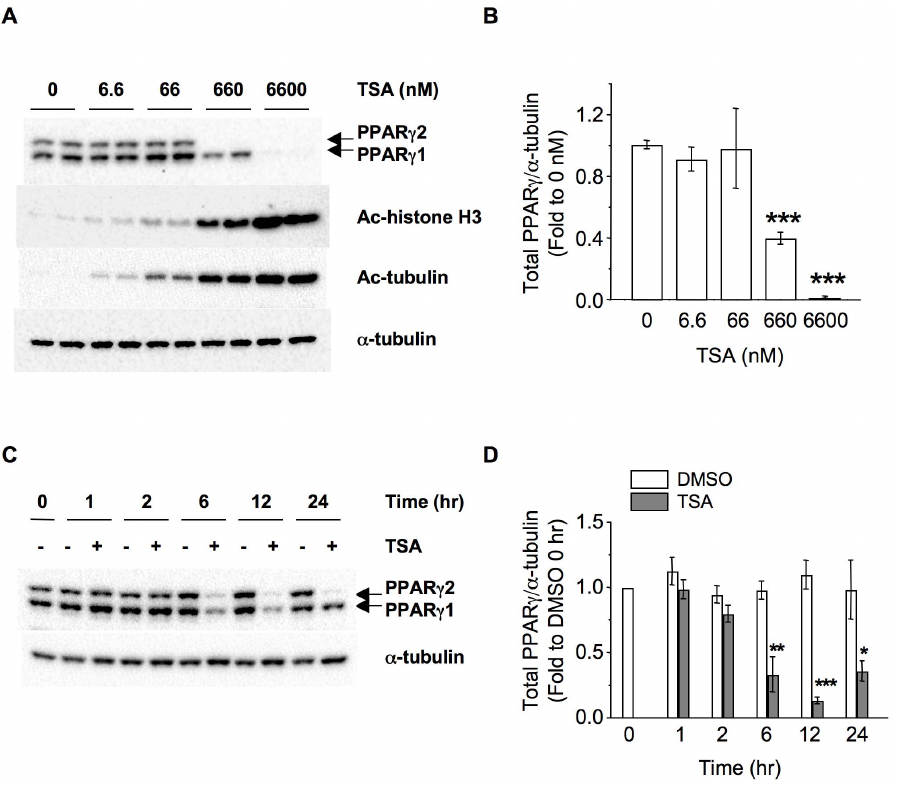
Figure 6. Down-regulation of PPAR c by TSA treatment is dose- and time- dependent. (A, B) 3T3-L1 adipocytes were treated in duplicate with increasing TSA doses (0, 6.6, 66, 660, 6600 nM) for 24 h. Cellular proteins were solubilized and subjected to SDS-PAGE and Western blot analysis with the indicated antibodies. Representative immunoblots from three independent experiments were shown in 6A. Quantification data for total PPAR c are shown in 6B. Asterisks denote significant differences compared with 0 nM control (***p , 0.001). (C, D) 3T3-L1 adipocytes were treated with vehicle (DMSO) or 660 nM TSA (TSA) for 0, 1, 2, 6, 12, or 24 h. Cellular proteins were solubilized and subjected to SDS-PAGE and Western blot analysis with the indicated antibodies. Representative immunoblots from four independent experiments were shown in 6C. Quantification data for total PPAR c are shown in 6D. Asterisks denote significant difference compared with corresponding DMSO value at the same time point (*p , 0.05; **p , 0.01; ***p ,